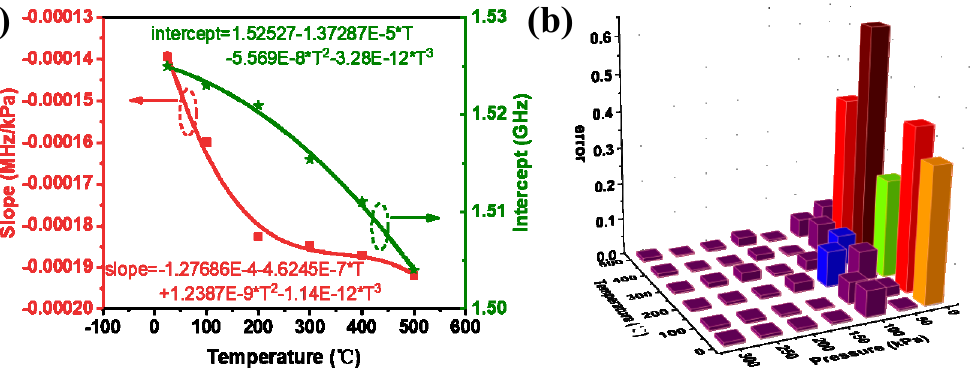
Figure 9. ( a ) Polynomial fitting slopes and intercepts for curves of pressure versus resonant fre- quency under different temperatures.; ( b ) nonlinearity errors in the pressure range of 10 − 300 kPa at 25 − 500 °C.